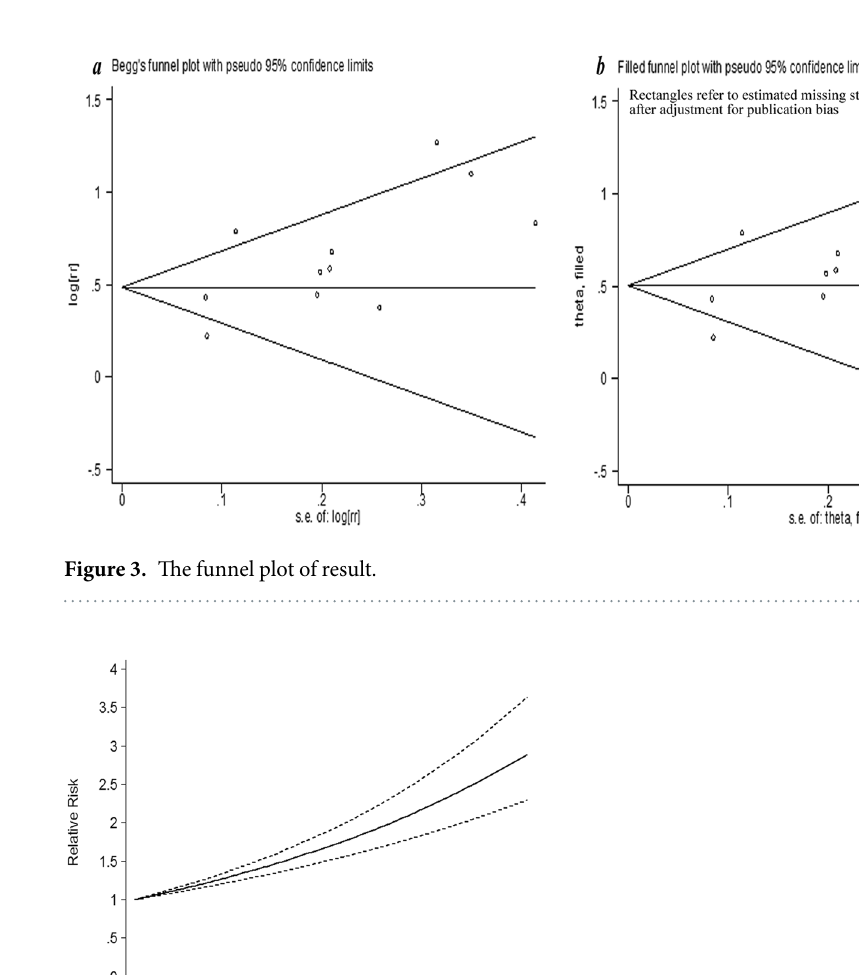
Figure 2. Association between Hcy levels and all-cause mortality risk analyzed by forest plot.